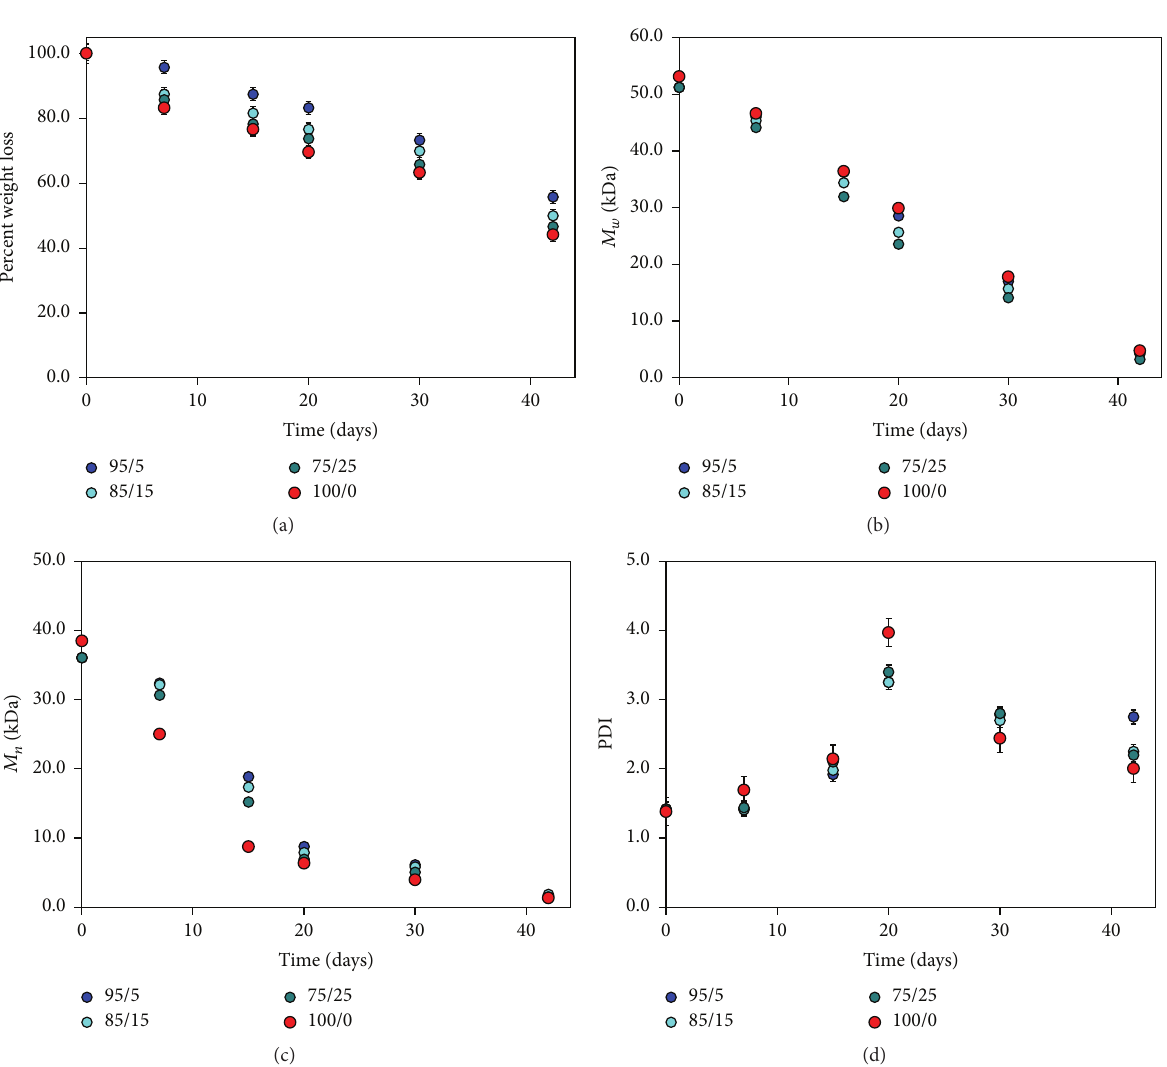
) as function with time; (c) w